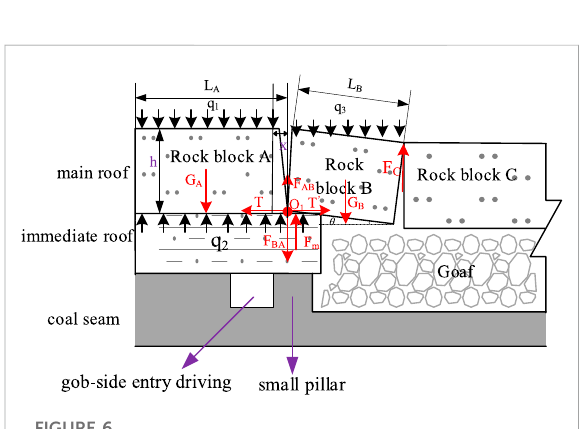
FIGURE 6 Diagram of the vertical stress mechanical model of a coal pillar. Physical quantity annotation: q 1 , overburden load on rock block A, MPa; q 2 , the support load of the direct roof to block A, MPa; q3, loading of overlying strata on rock block b, MPa; L A , length of rock block A, m; L B , length of rock block B, m; G A , the weight of rock block A, N; G B , self-weight of rock block B, N; F BA , thevertical forceofrockblock Bon A,N;F CB ,vertical forceofrock blockConB,N;F m ,thestresstransferredfromthebasictoptothe coalpillar,N;F C ,thestresstransmittedbythegangueinthegoafto the rock block B, N; X A , the distance between the load force position transmitted byrockblock A to coal pillar andthe rightend of rock block A, m; X B , the distance between the load force position transmitted by rock block B to coal pillar and the left end of rock block B, m; t, the horizontal force between block A, B, and C, N; θ − rotation angle of rock block B, ° ; h, the thickness of rock blocks A, B and C,